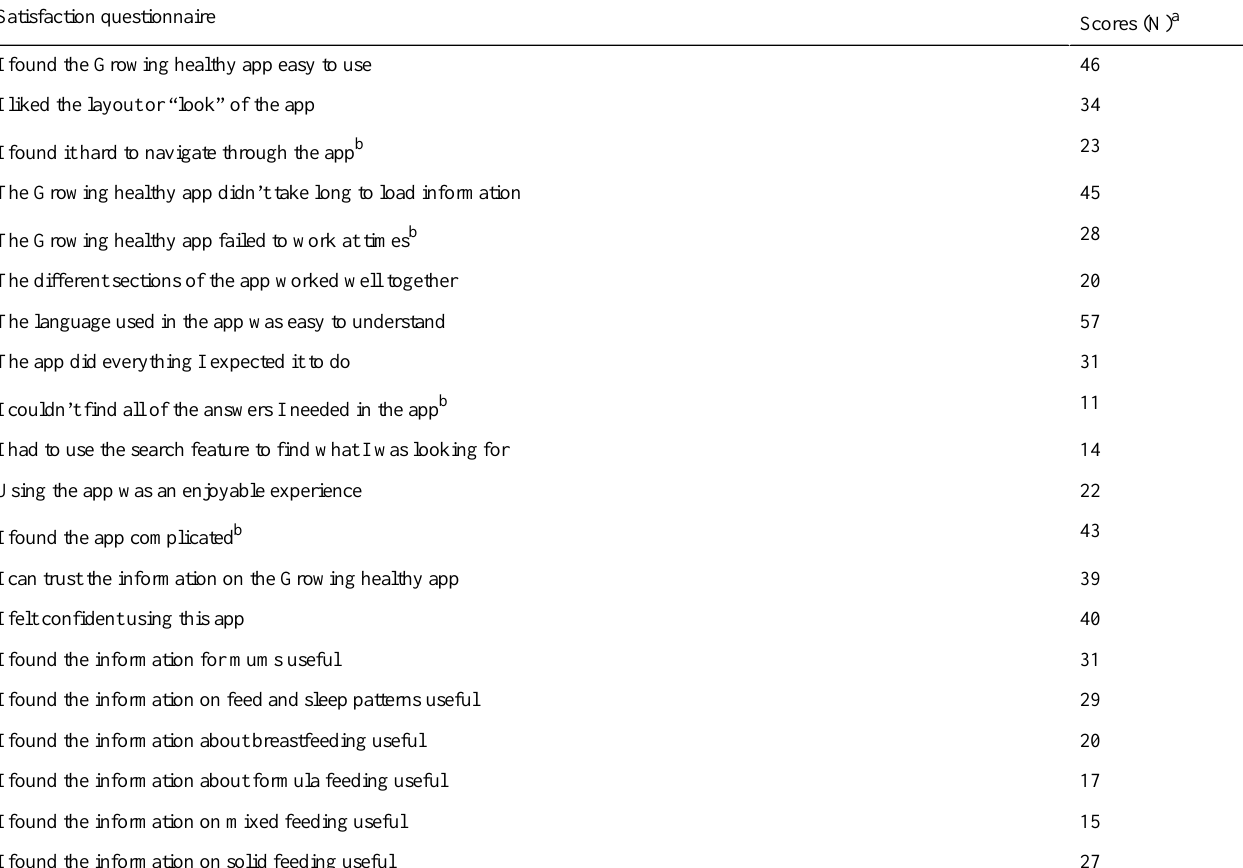
Table 4. Participants’reported satisfaction with aspects of the Growing healthy program (feedback index, F i ; n=154).